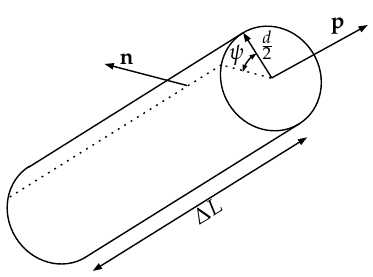
Figure 3. Cylindrical fiber segment with length ∆ L , orientation p and an arbitrary surface normal n .